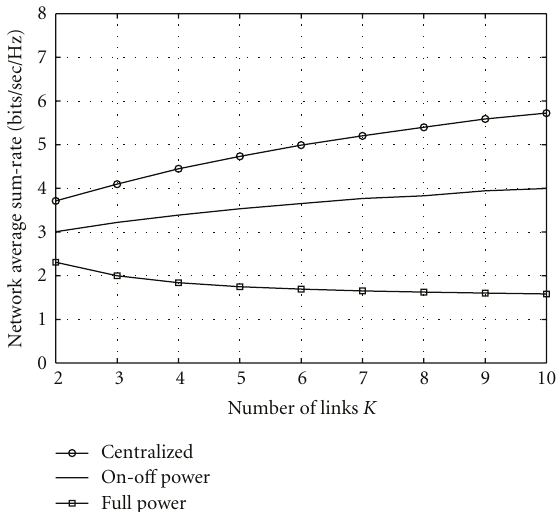
Figure 3: Average sum-rate of the network versus the number of links K for di ff erent power allocation